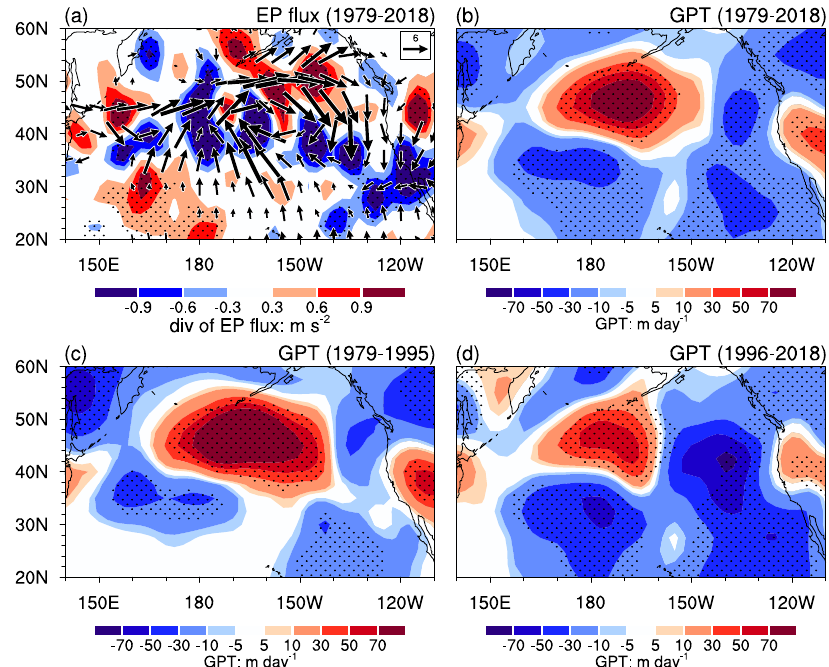
Fig. 3 Interaction between synoptic-scale eddy and low frequency fl ow over North Paci fi c associated with the early-spring ALI. Anomalies of a extended EP fl ux (vectors, m 2 s − 2 ) and divergence of the extended EP fl ux (shadings, m s − 2 ), and b geopotential height tendency (m day − 1 ) at 300 hPa in Mar(0) regressed onto the normalized ALI in Mar(0) over 1979 – 2018. c – d as in b , but over 1979 – 1995 and 1996 – 2018, respectively. Stippling region in a indicates EP fl ux divergence anomalies signi fi cant at the 95% con fi dence level. Stippling regions in b – d indicate geopotential height tendency anomalies signi fi cant at the 95% con fi dence